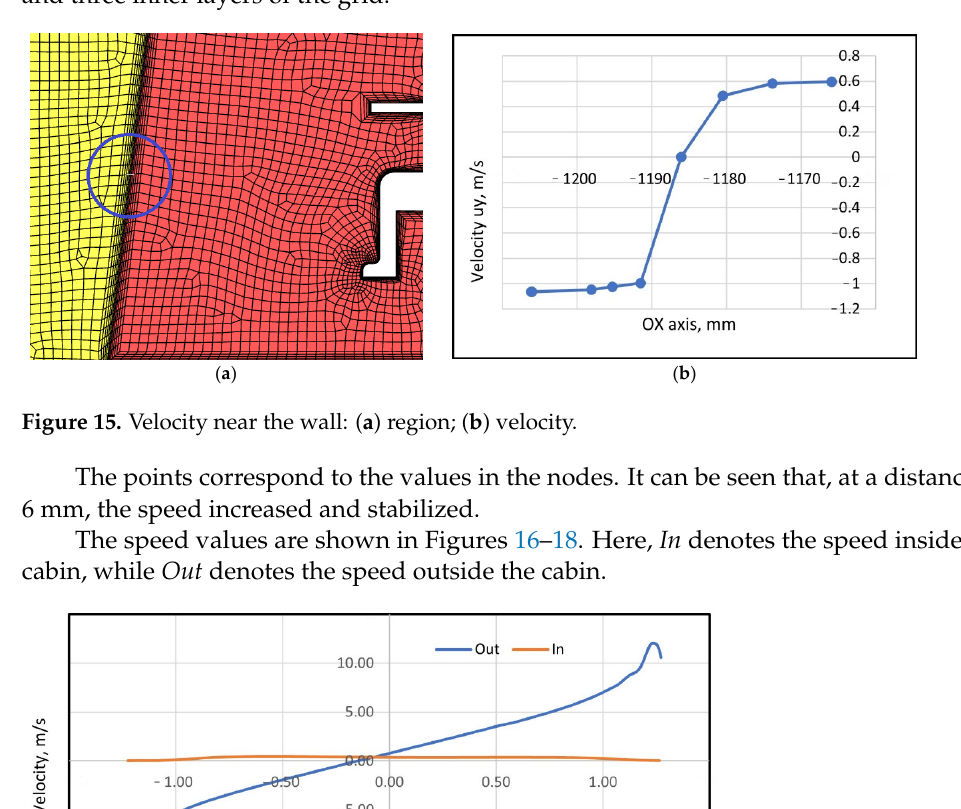
Figure 16. Velocities along the left wall.